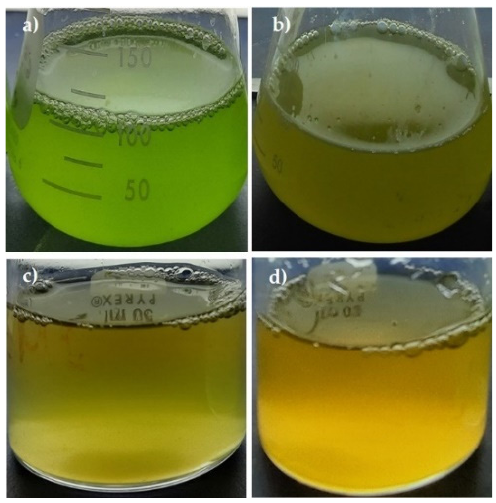
Figure 3. Cultures of D. salina on glycerol and controls. ( a ) IM, 1.5 M NaCl and 50 μ mol m − 2 s − 1 . ( b ) Gly, 3.0 M NaCl and 50 μ mol photons m − 2 s − 1 . ( c ) IM, 1.5 M NaCl and 300 μ mol photons m − 2 s − 1 . ( d ) Gly, 3.0 M NaCl and 300 μ mol photons m − 2 s − 1 . The images were captured on the seventh day of culture when the pigments were analyzed. ( a ) and ( b ) correspond to the original culture flasks, whereas ( c ) and ( d ) are recipients only used for photography.